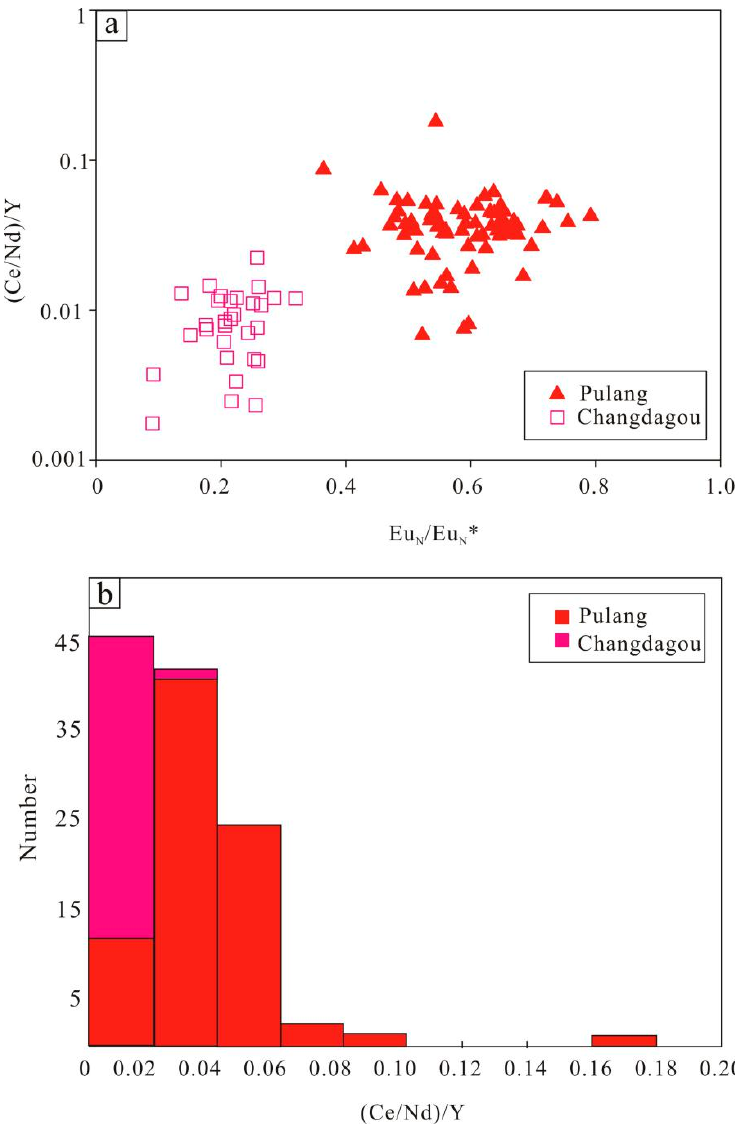
Figure 7. ( a ) ( Ce/Nd)/Y vs. Eu N /Eu N * diagram of zircon grains for the Changdagou and Pulang Figure 7. ( a ) (Ce / Nd) / Y vs. Eu N / Eu N * diagram of zircon grains for the Changdagou and Pulang porphyries; ( b ) histogram of ( Ce/Nd)/Y values. porphyries; ( b ) histogram of (Ce / Nd) / Y